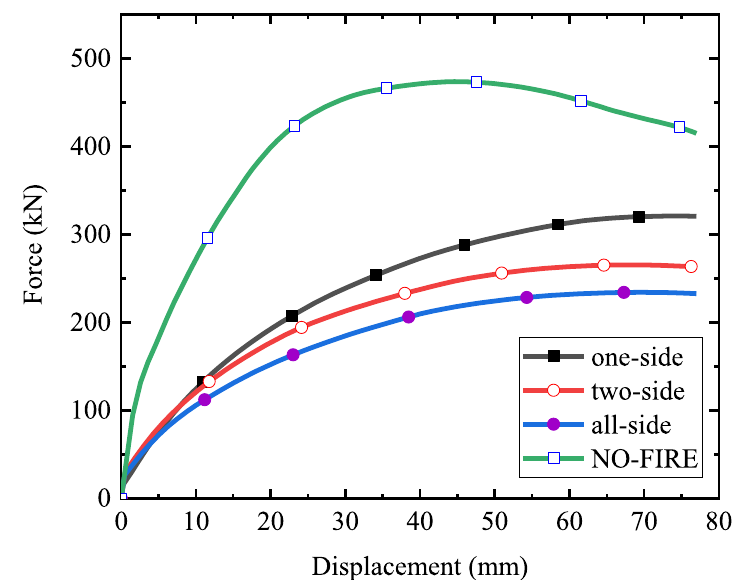
Fig. 43 Load-displacement curves for different fire exposure sides